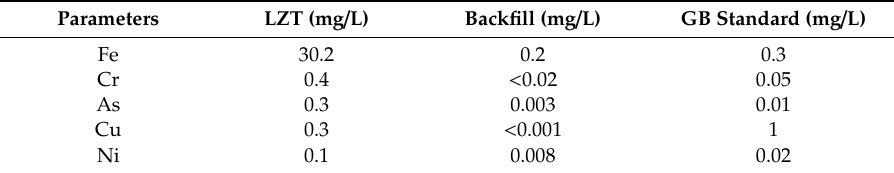
Table 5. Metal concentrations in the static leachate of lead–zinc tailing (LZT) and backfill samples after 48 h.